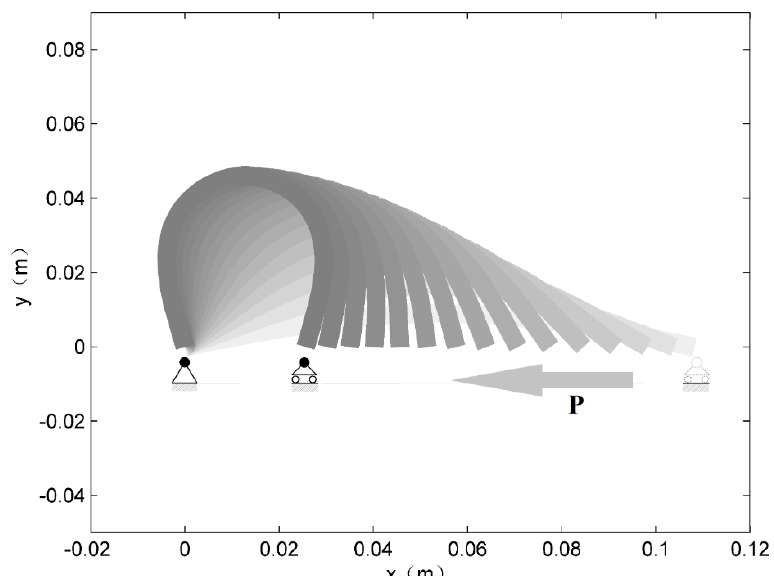
Figure 2. Axial compression deformation of SGC.